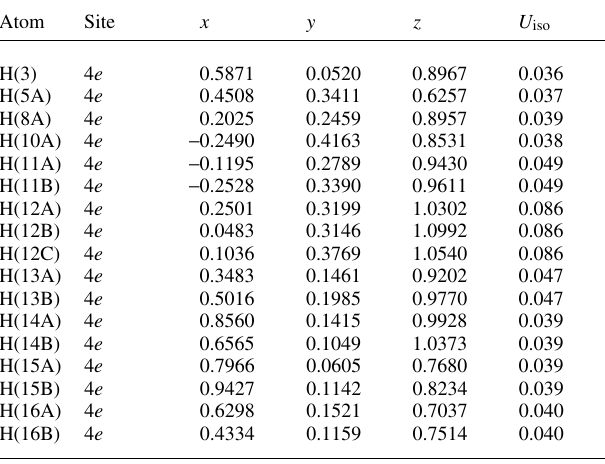
Table 2. Atomic coordinates and displacement parameters (in Å 2 )